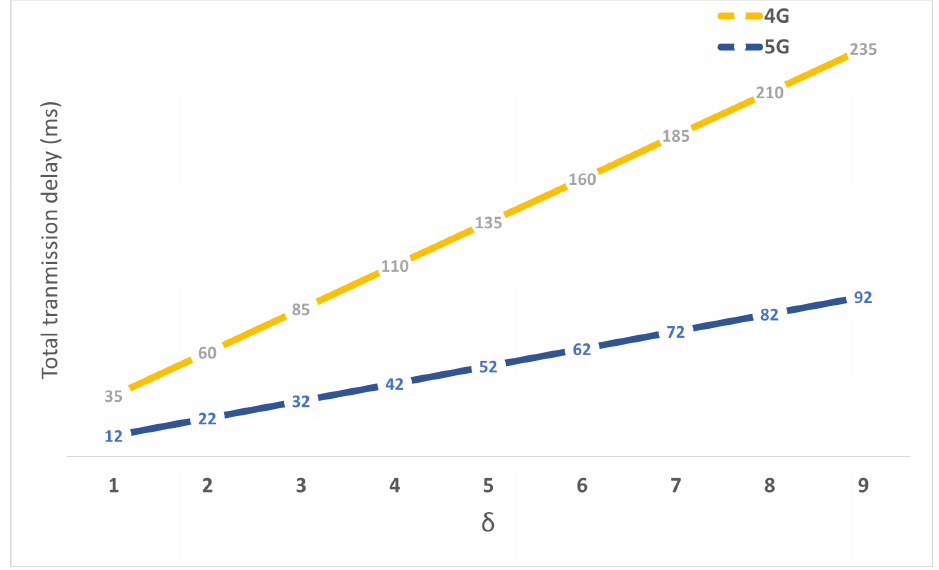
Figure 11. The impact of varying δ on the total transmission